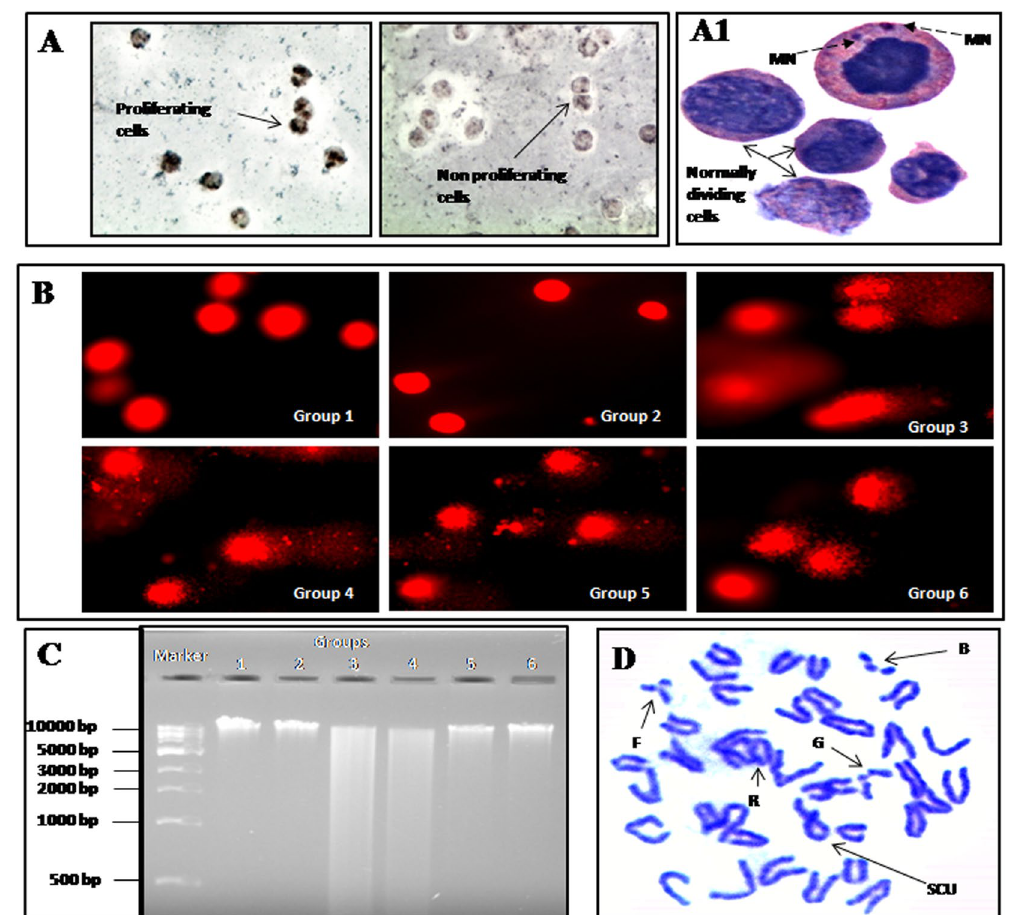
Figure 2. Effect of MUS on CBDCA-induced cytotoxicity and clastogenic effect in murine bone marrow cells. ( A ) Representative photomicrograph (taken at 400 × magnification) of cell proliferation, where proliferating cells are BCIP/NBT stained and non-proliferating cells are unstained. ( A1 ) Representative photomicrograph for the formation of micronuclei (indicated by broken arrow) after CBDCA treatment (1000X). ( B ) Effect of MUS on CBDCA-induced DNA damage in murine bone marrow cells. Photomicrographs after comet assay were taken at 400 × magnification. ( C ) Photomicrograph of agarose gel electrophoresis of genomic DNA. ( D ) Representative photomicrograph of chromosomal aberrations in a single metaphase plate taken at 1000 × magnification. Different anomalies like break [B], sister chromatid union [SCU], fragmentation [F], gap [G] and ring [R] are